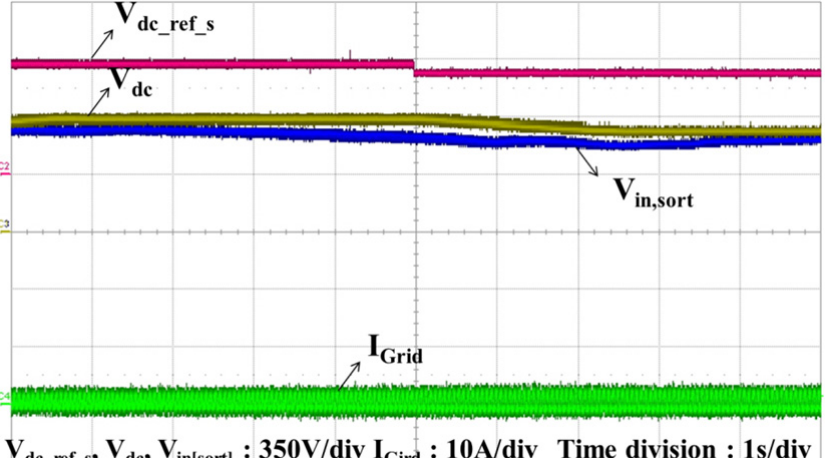
sort and V from in , ref_dc_s